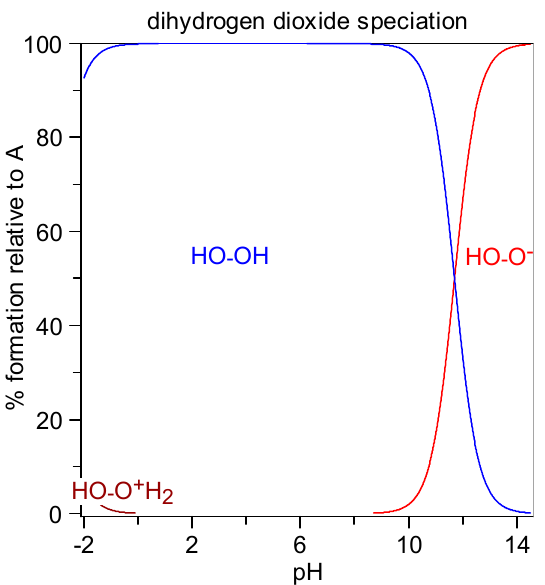
Figure 6. Diagram of dihydrogen dioxide distribution: percent species formation calculated with the HySS program (Alderighi et al., 1999) [47] for a 10 millimolar solution of H 2 O 2 (pK a1 = − 3.1, pK a2 = 11.7).